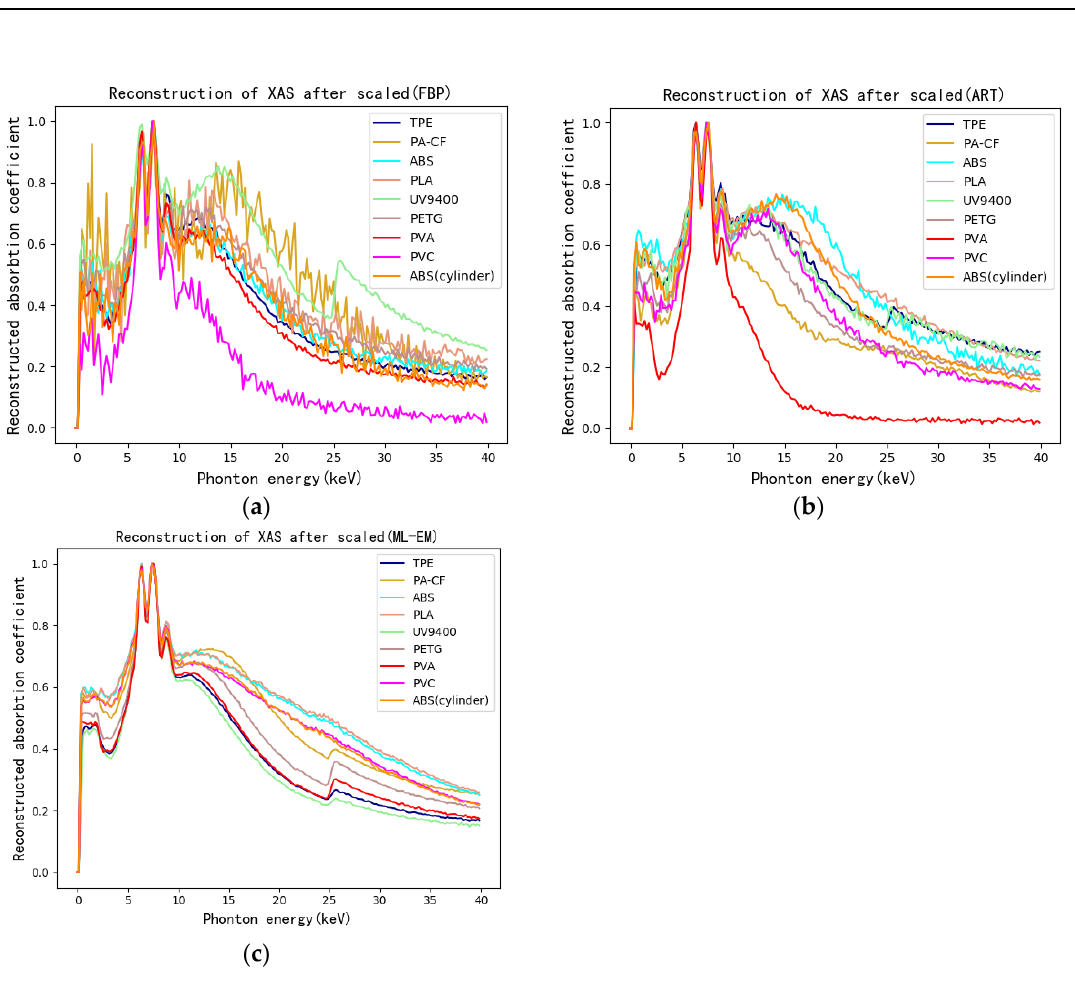
Figure 10. ( a ) Reconstructed XAS of ROI on the CT image of test-set specimens by FBP and ART ( b ) as well as ML-EM ( c )